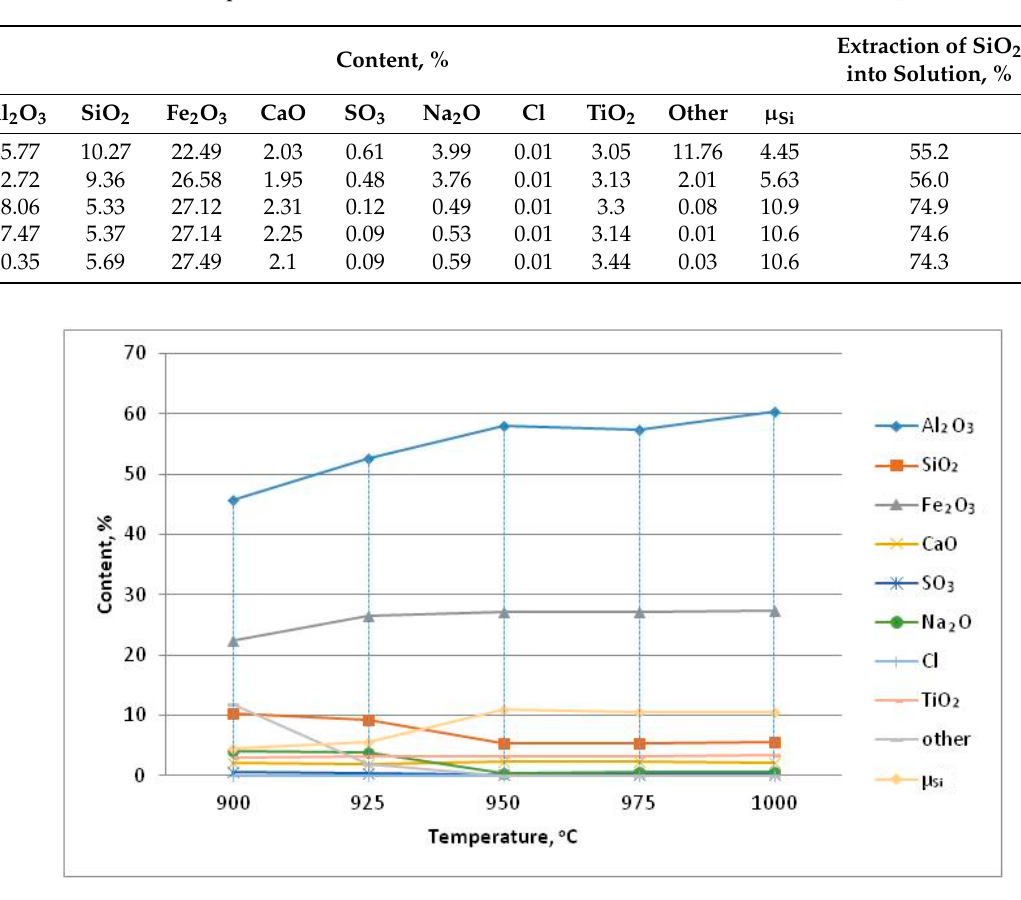
Figure 9. The composition of bauxite after chemical beneficiation.